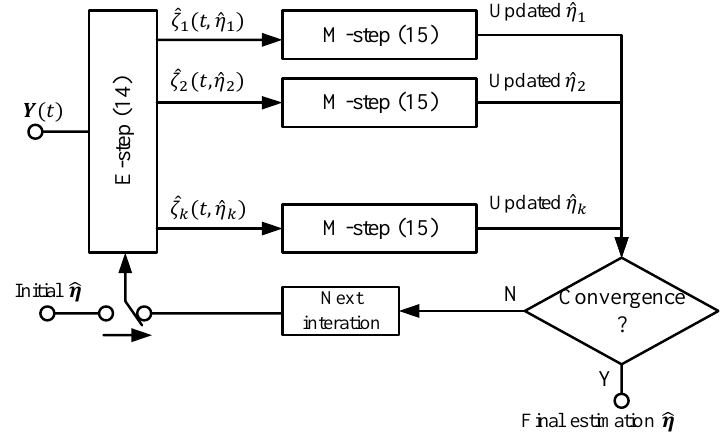
Figure 3. The signal flow of the EM algorithm. This processing flow was also used in